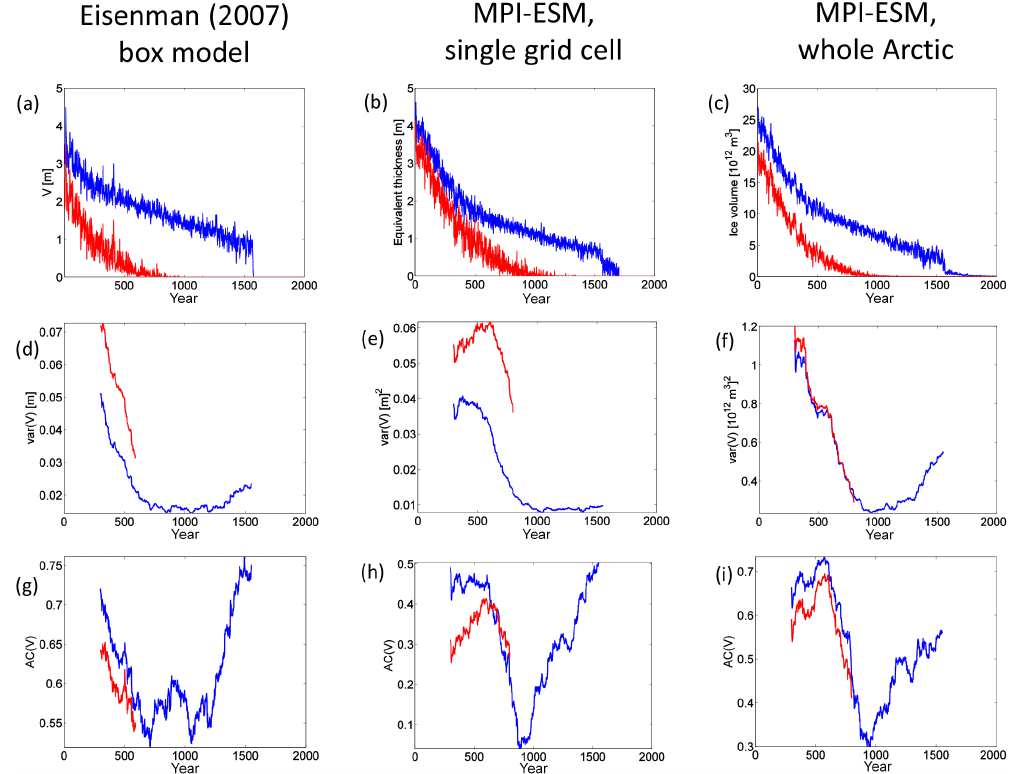
Figure 6. Time series from transient simulations with the box model by Eisenman (2007) (left column) and MPI-ESM (middle and right column). (a–c) Evolution of ice volume; (d–f) variance; (g–i) autocorrelation of this volume as obtained from a sliding window approach. Winter sea ice is shown in blue and summer sea ice in red. The single grid cell in MPI-ESM (second column) is located at 86.5 ◦ N and 102 ◦